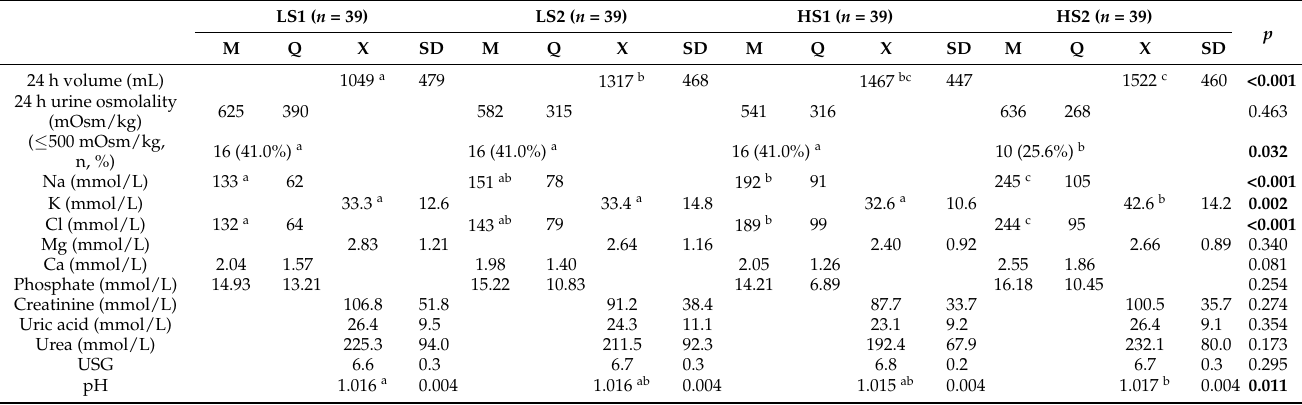
Table 3. The characteristics of 24 h urine among participants.